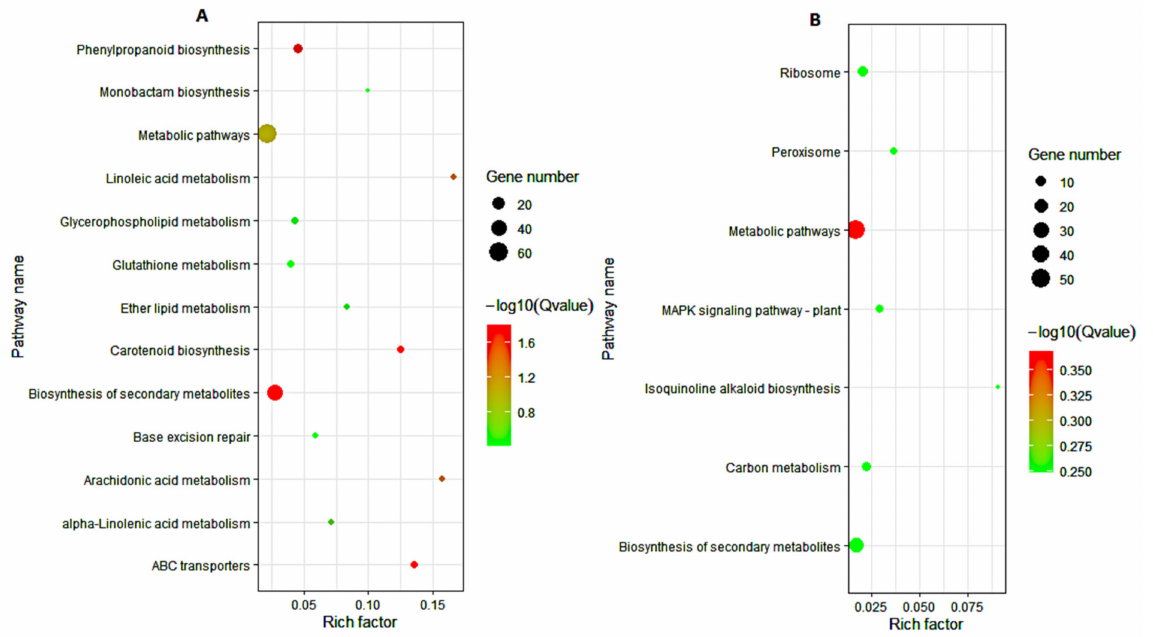
Figure 8. KEGG pathway enrichment analysis. ( A ) The 779 DEGs highly enriched in the tolerant lines. ( B ) The 877 DEGs highly enriched in the sensitive lines. The experimental comparisons were based on the hypergeometric test, while the significance of the enrichment of the KEGG pathway was based on q value, q < 0.05. The color gradient represents the size of the q value; the color ranges from green to red, and the closer to green, the smaller the q value and the higher the significant degree of enrichment of the corresponding KEGG pathway. The “rich factor” represents the percentage of DEGs to total genes in a given